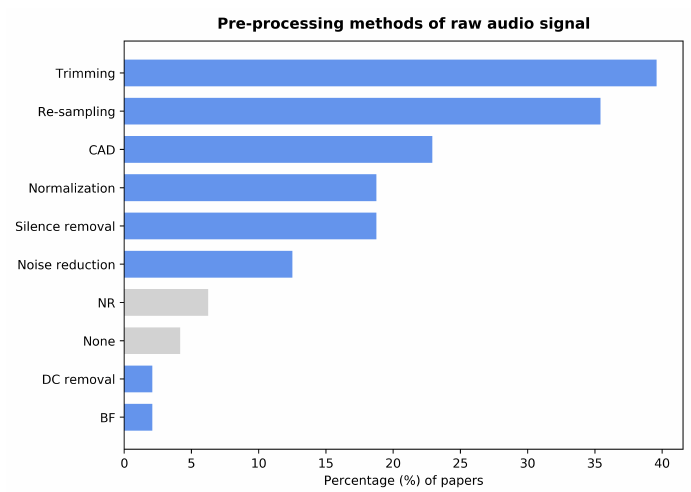
Figure 3. Bar graph showing the percentage of papers that employ each of the pre-processing techniques. Trimming : manual segmentation of the raw audio signal. Re-sampling : reduction of the sampling rate of the raw audio signal. CAD : algorithm-based Cough Automatic Detection method. Normalization : amplitude normalization of the raw audio signal. BF : application of a low-pass Butterworth filter. Silence removal : algorithm-based method to remove silence parts of the raw audio signal. DC removal : subtraction of the DC part of the raw audio signal. None : papers that report using the raw audio signal for feature extraction. NR : papers that did not report any